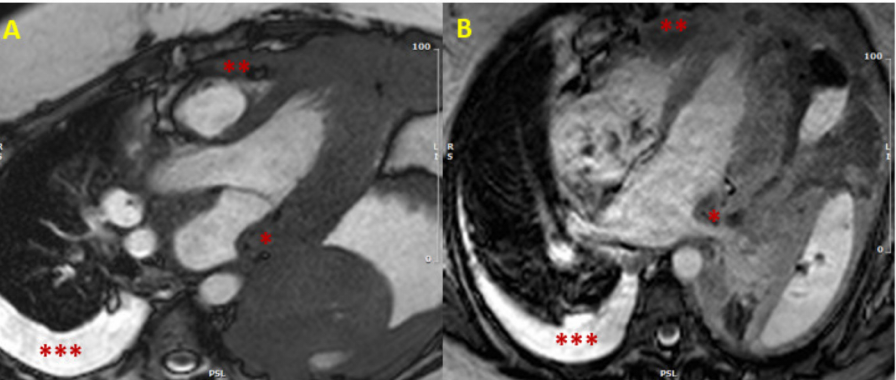
Figure 1. Cardiac lymphoma at CMR. SSFP images in long axis (3-chamber view in Panel ( A ), and 4-chamber view in Panel ( B )) showing concomitant hypertrophy of left atrial wall (single asterisk *) and RV (two asterisks **). The presence of multiple areas of hypertrophy and pleural effusion (three asterisks ***) are “red flags” for malignancy. (CMR = cardiac magnetic resonance; SSFP = steady-state free precession; LV = left ventricle; RV = right